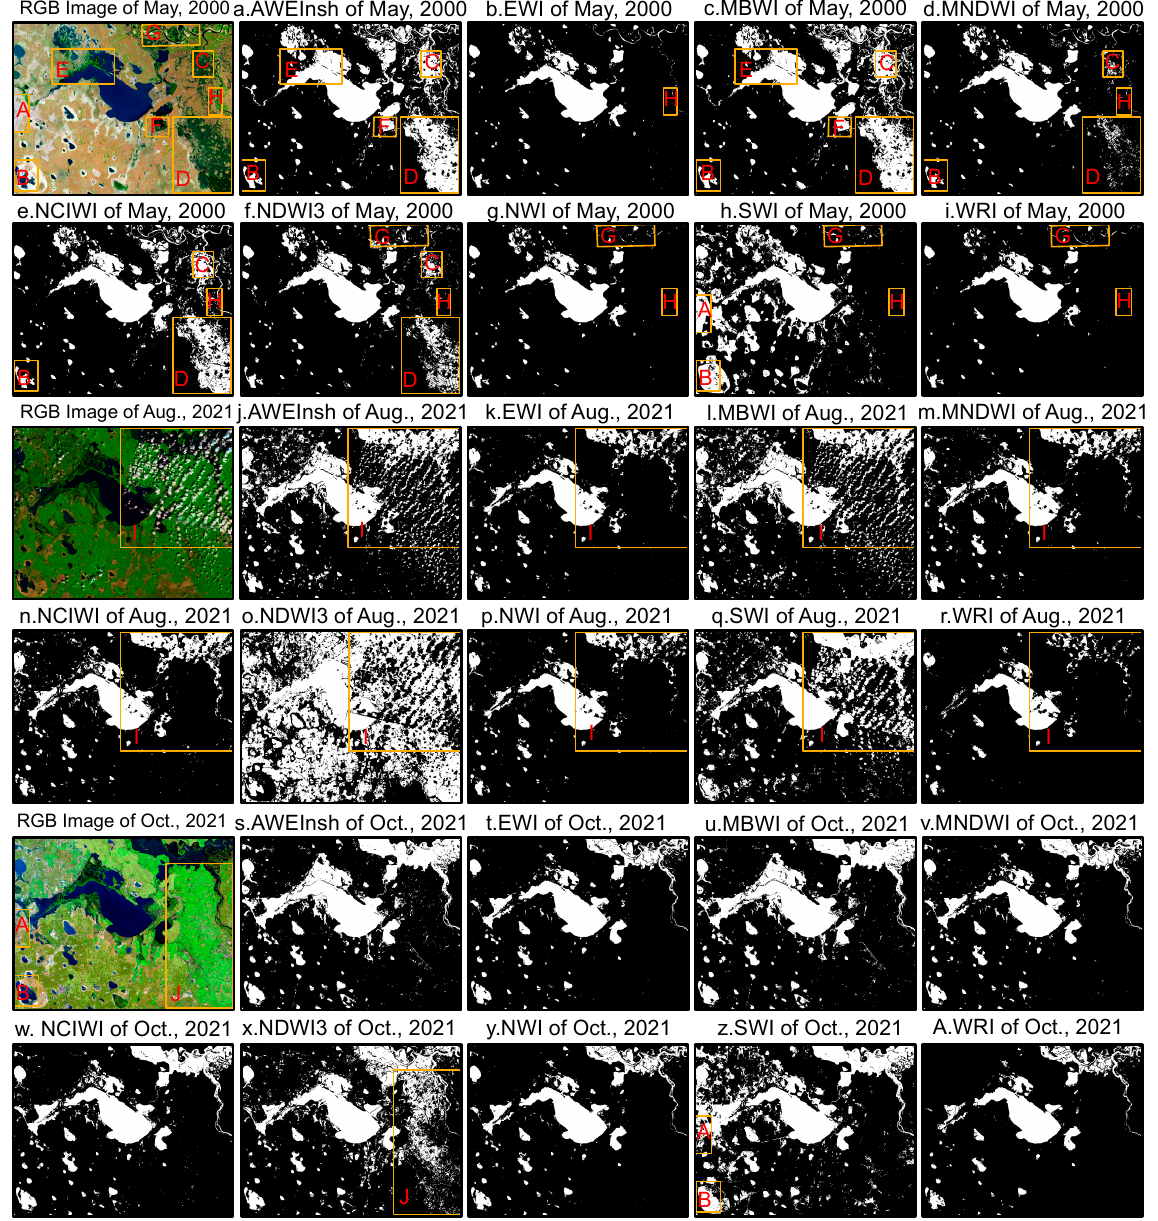
Figure 13. RGB (band 752 in Table 1) images and waterextraction maps of the study area of Chagan Lake in different water periods based on AWEInsh ( a , j , s ), EWI ( b , k , t ), MBWI ( c , l , u ), MNDWI ( d , m , v ), NCIWI ( e , n , w ), NDWI3 ( f , o , x ), NWI ( g , p , y ), SWI ( h , q , z ) and WRI ( i , r , A ) with their optimal segmentation thresholds. The orange boxes and the red uppercase letters on the maps within the boxes (A–J) are used to mark the typical regions where CE or OE occurs.